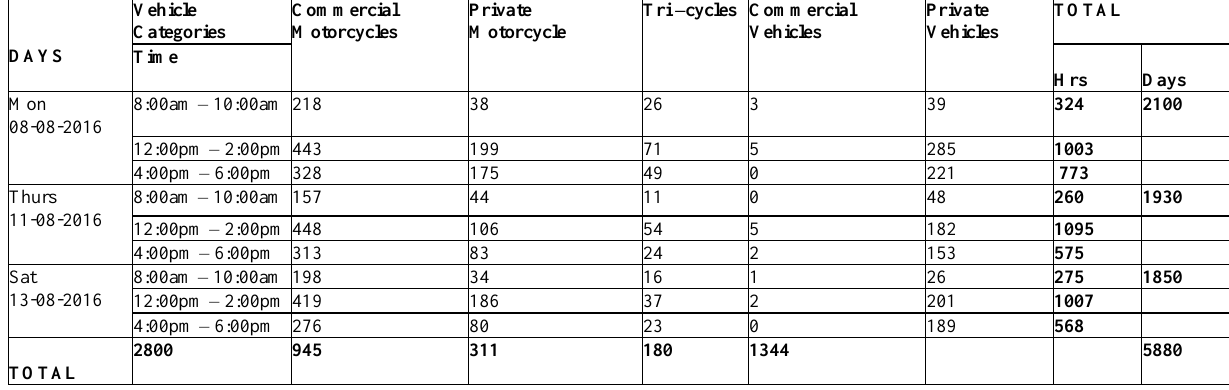
Table 1. Red Light Running Along Shiroro Road, Minna. Source: Medayese et al.,